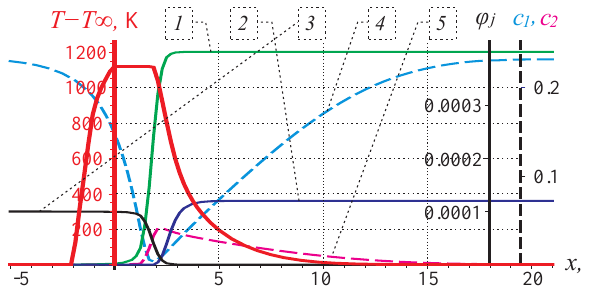
Figure 1. Initial distributions of volume fractions of the multiphase environment and concentration of gas phase components. The temperature is shown by a continuous thick line; numbers 1, 2, 3 denote the curves corresponding to dry organic substance of combustible forest materials, water in an liquid-drop condition, coke; 4, 5 illustrate concentration of oxygen, carbon